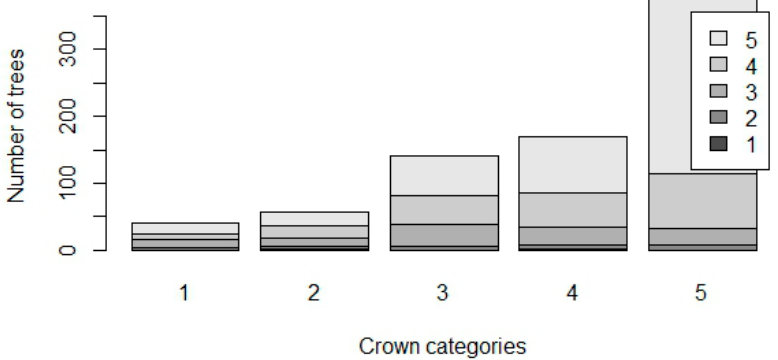
Figure 8. Barplot for the contingency table shows the relationship between the crown categories ( x -axis) and trunk categories (side colors with trunk categories; p -value = 8.632 × 10 − 12 ; field measurements).